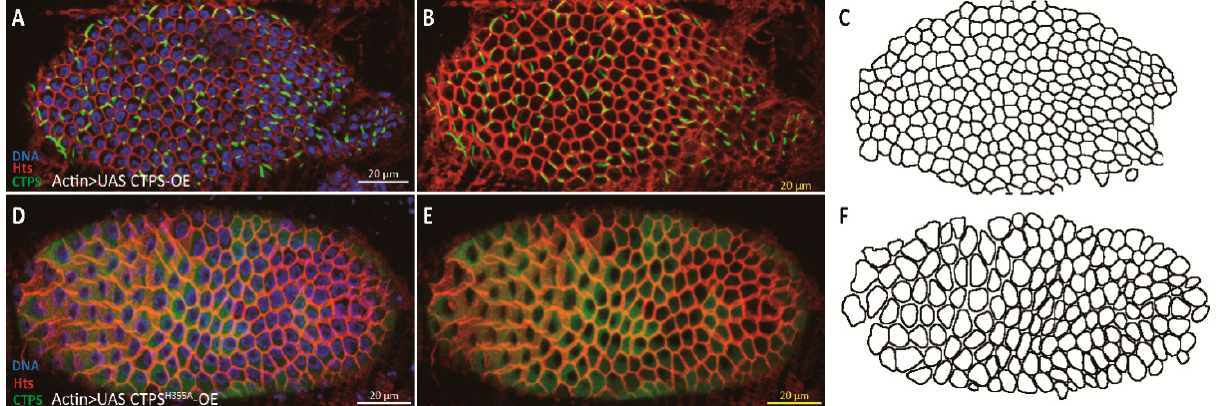
Figure 10. The integrity of follicle epithelium is compromised when overexpressing CTPS H355A . ( A – C ) Surface view of a stage 8 egg chamber with follicle cells overexpressing CTPS . Large cy- toophidia are detectable in almost all follicle cells. ( D – F ) Surface view of a stage 8 egg chamber with follicle cells overexpressing CTPS H355A . Note that the heterogenous sizes of follicle cells and increased gaps between neighbouring follicle cells. CTPS-mCherry (green), Hts (red) and DNA (blue, labelled with Hoechst 33342). Scale bars, 20 μ m.